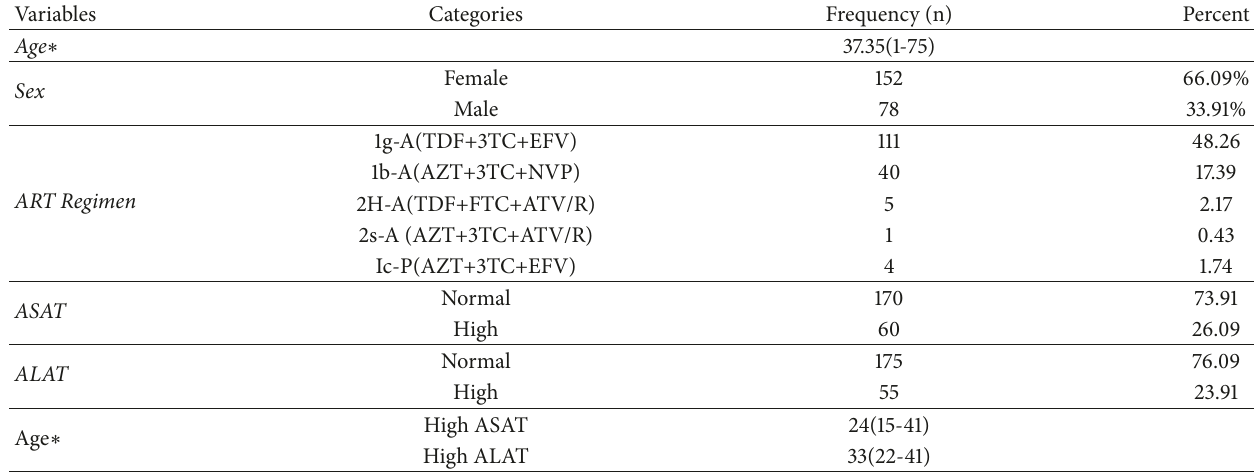
Table 1: Demographic and clinical characteristics of HIV positive individuals in the lake zone